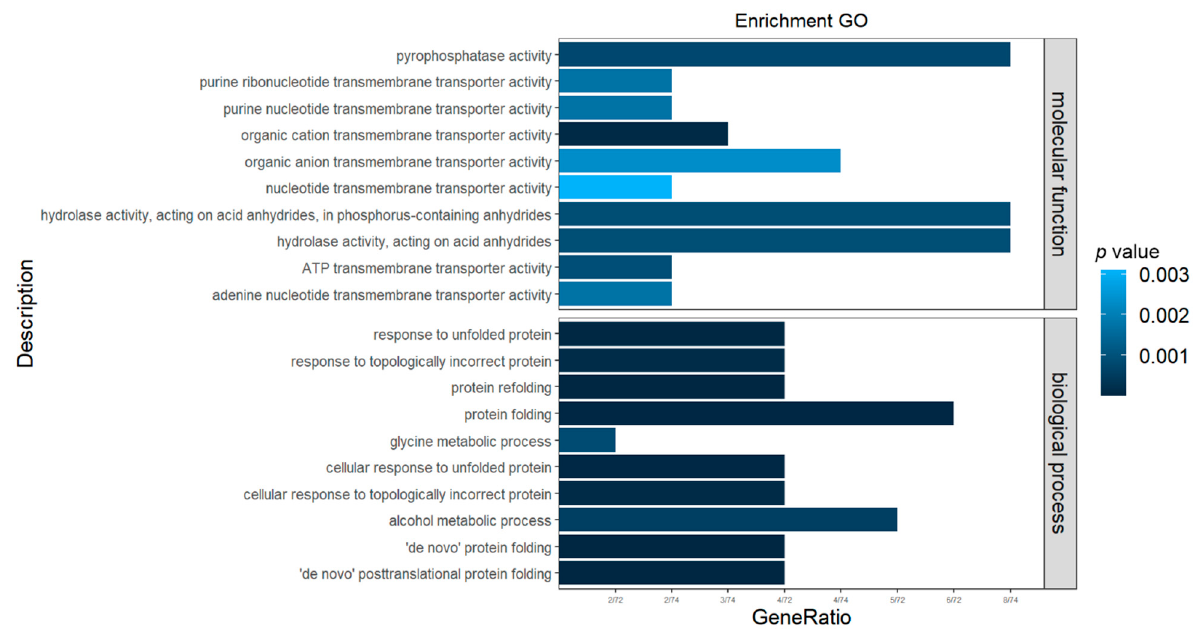
Figure 2. Go enrichment analysis.